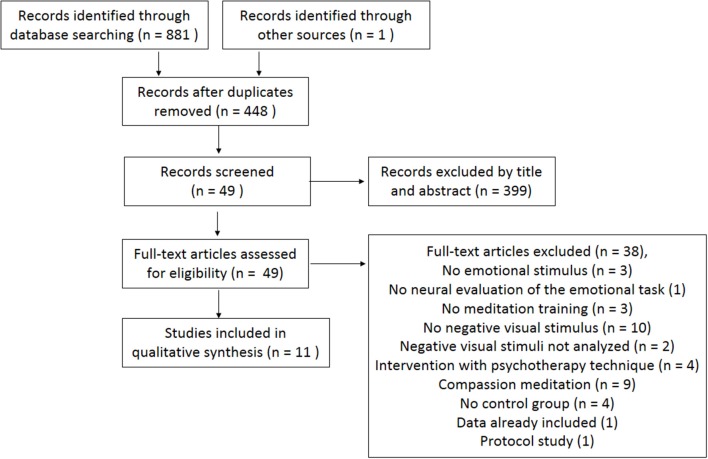
PRISMA flow diagram of the literature search (Moher et al., 2009).